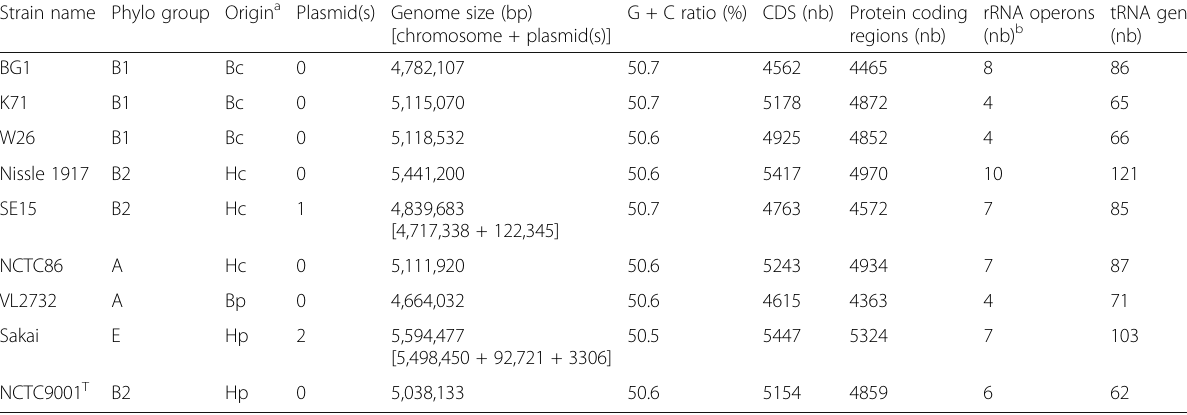
Table 5 Characteristics of whole genome datasets of different E. coli strains Strain name Phylo group Origin a Plasmid(s) Genome size (bp)